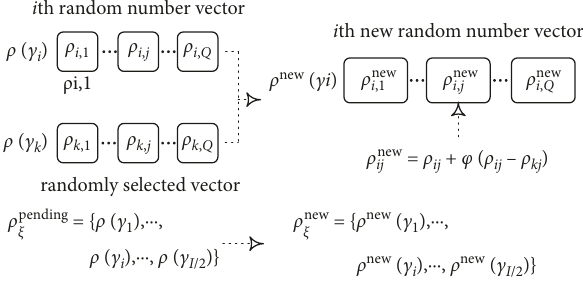
Figure 6: New random number vector